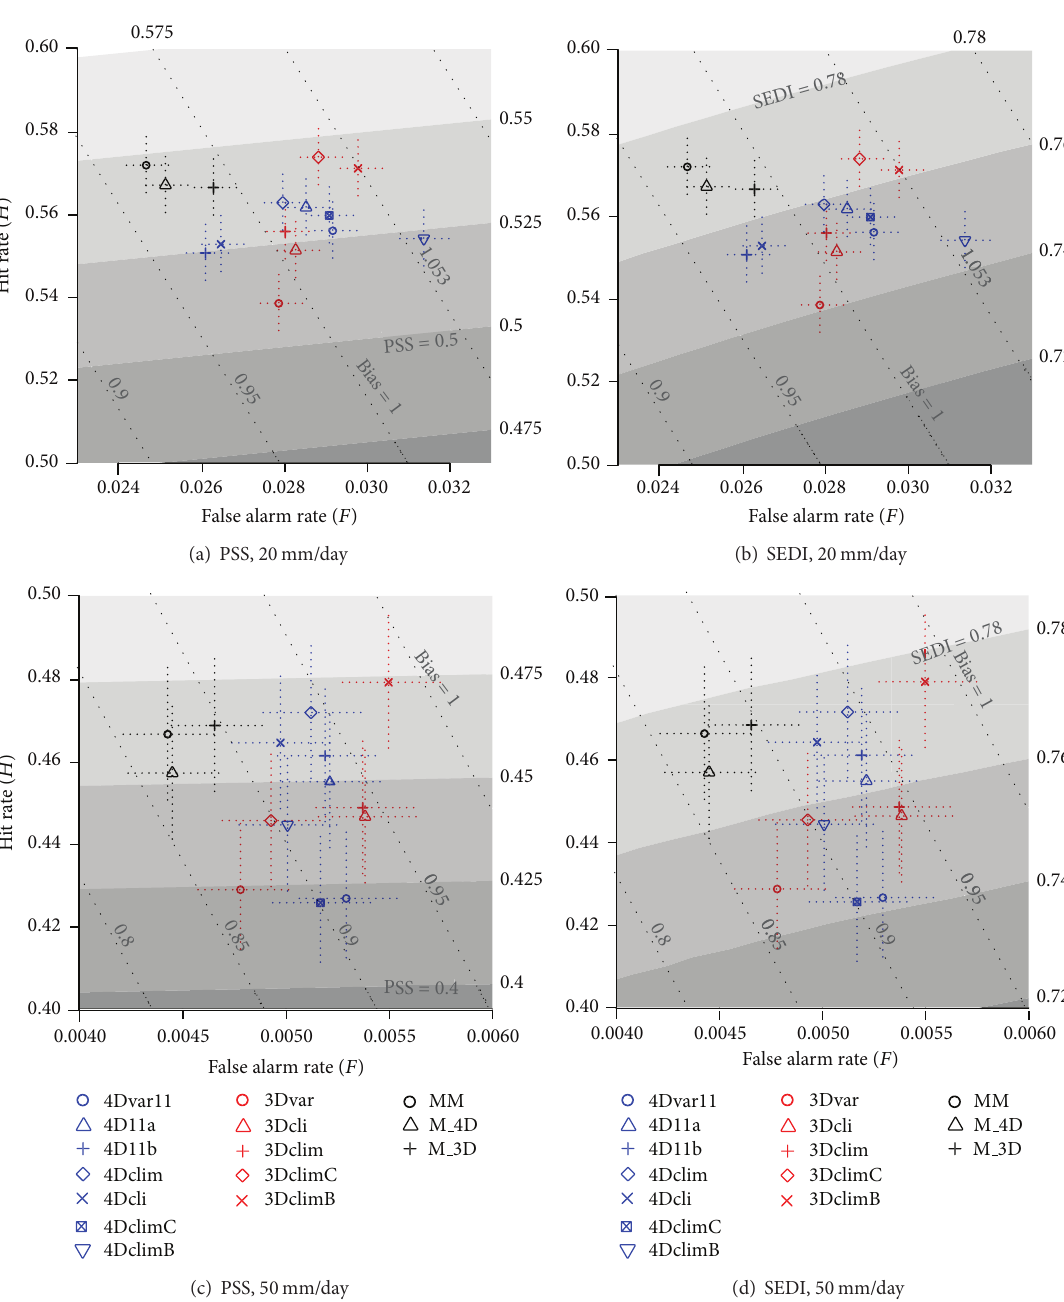
Figure 7: Relative operating characteristic (ROC) diagrams including all of New Zealand for the mod-heavy (a and b) and heavy (b and c) rainfall thresholds. Bias is shown by the grey dotted lines and two different measures of forecast skill, PSS (a and c) and SEDI (b and d), are shown with